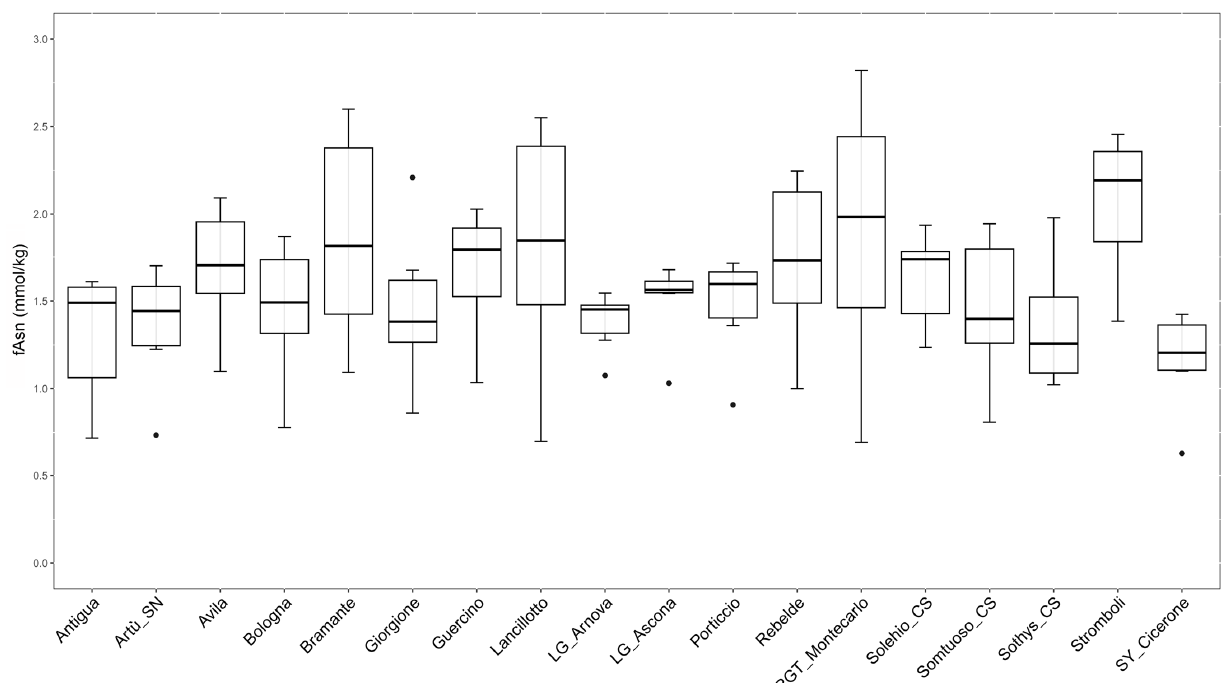
Figure 4. Box plots of fAsn measurements from the 18 genotypes present in the six field trials.